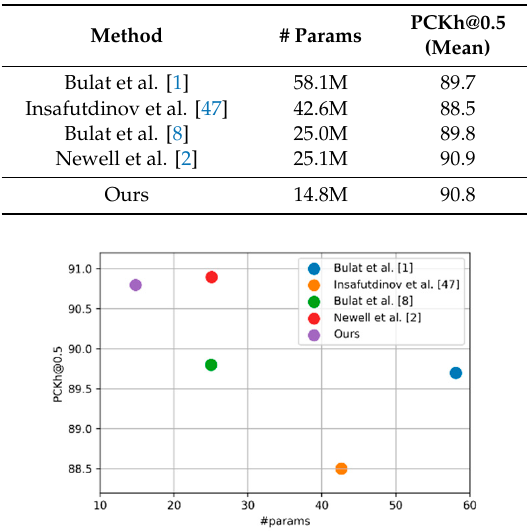
Table 8. Parameter and accuracy comparison with existing methods using the MPII validation dataset (PCKh@0.5).